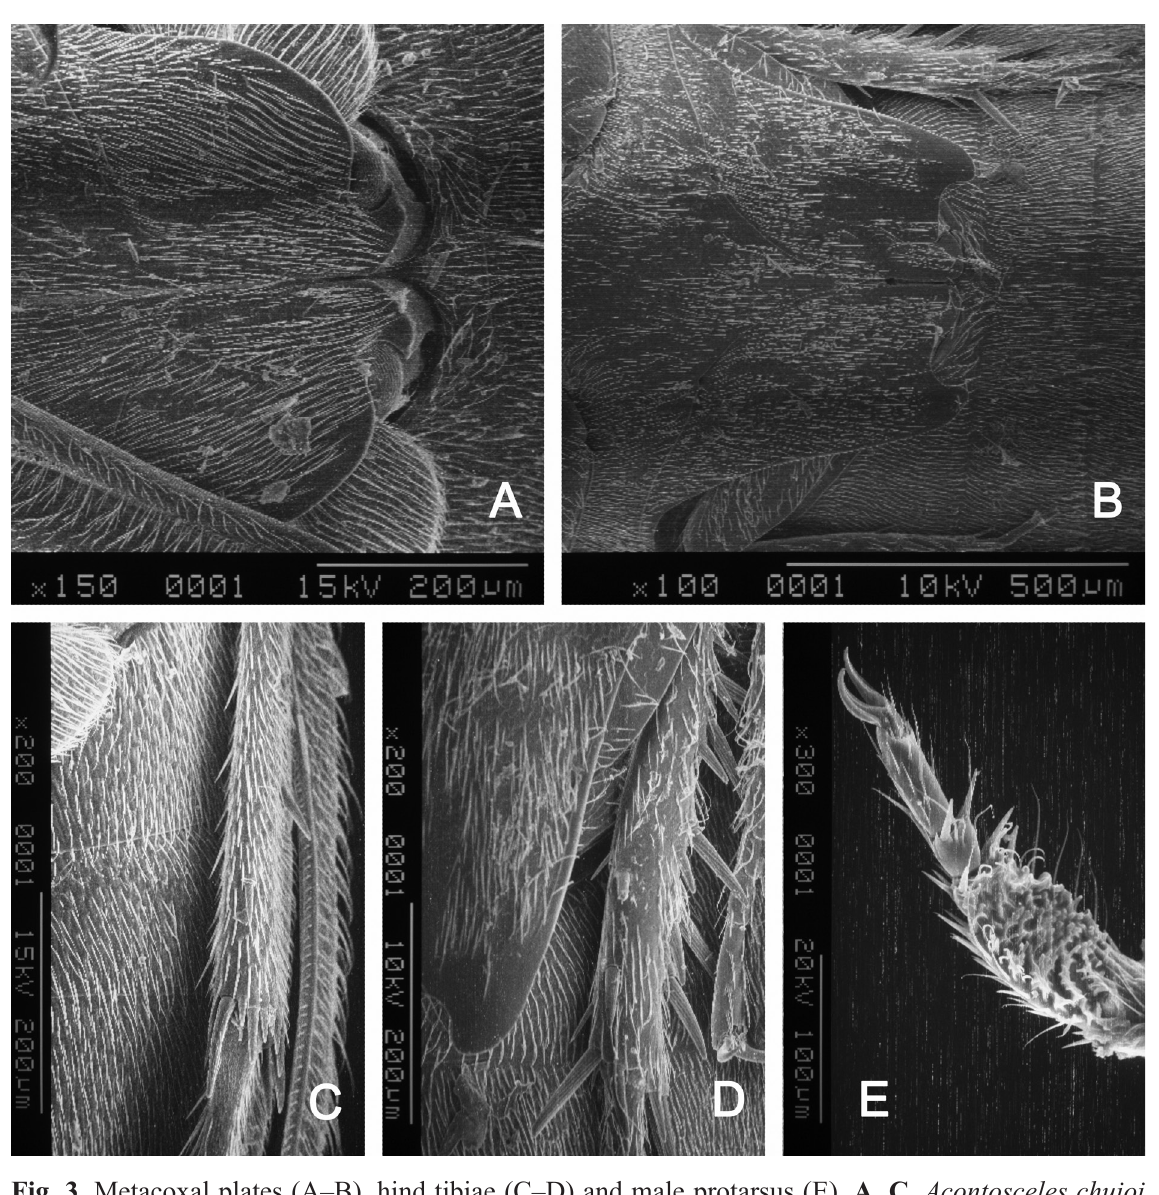
Fig. 3. Metacoxal plates (A–B), hind tibiae (C–D) and male protarsus (E). A, C . Acontosceles chujoi Yoshitomi & Satô, 2005. B, D . Mexico taiwanus (Satô, 1994). E . Pseudeucinetus zygops